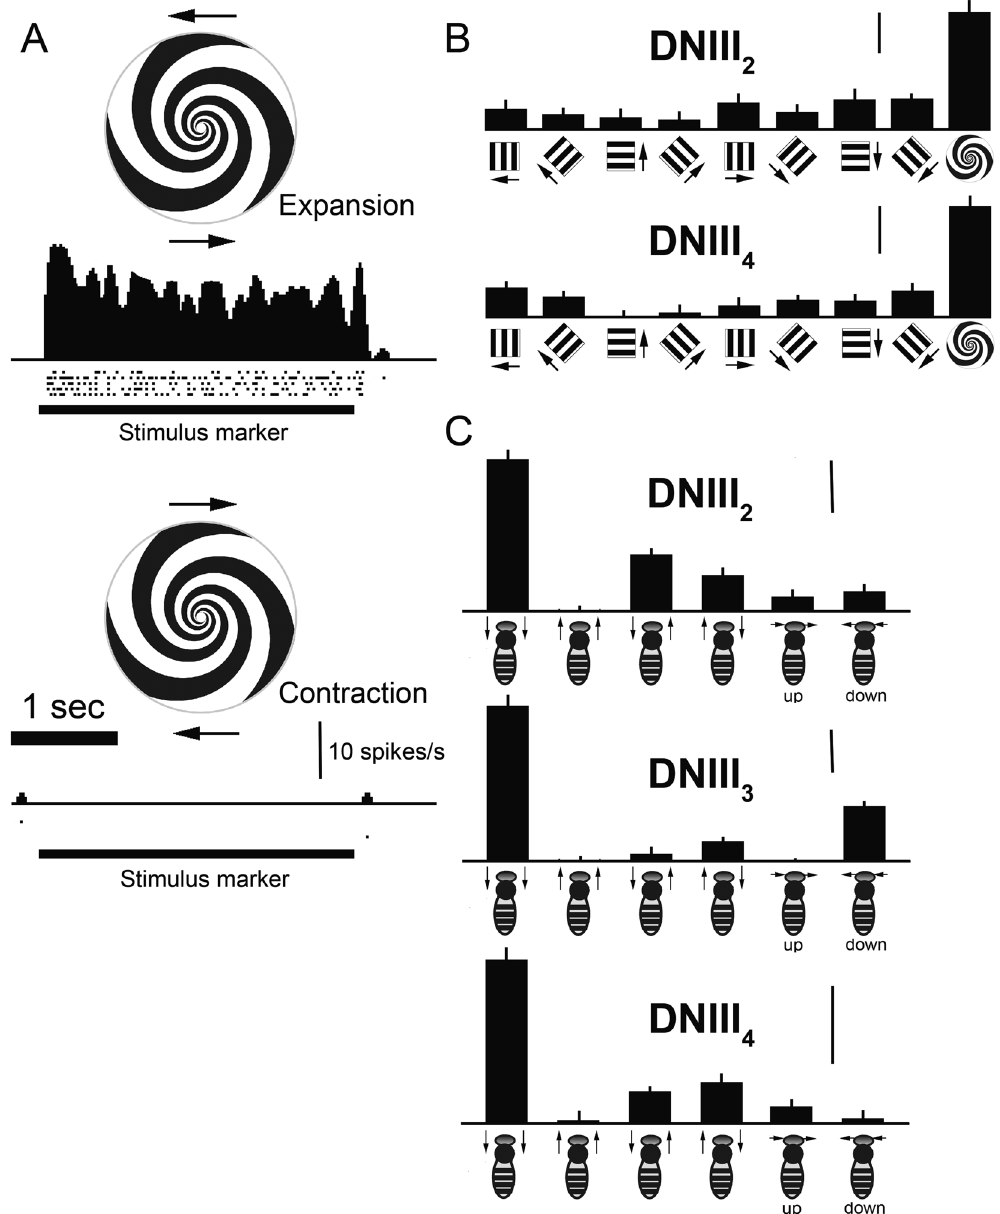
Figure 4. Directional tuning of DNIII neurons. ( A ) Response of a DNIII 4 neuron to expansion and contraction of the spiral pattern. The stimulus was repeated 5 times: rasters show actual spike arrival times and the spike density function shows the general response waveform. The spiral rotated at 1.5 revolutions per second. ( B ) Responses of DNIII 2 and DNIII 4 neurons, confirmed through anatomical identification of the brain anatomies, to frontal stimulation with gratings and spirals. ( C ) Responses of anatomically confirmed DNIII 2 , DNIII 3 and DNIII 4 neurons to lateral stimulation, as indicated. Error bars are standard errors. The vertical bars in ( B ) and ( C ) show 10 spikes/s. The stimuli in ( B ) and ( C ) were standardized gratings of 0.05 cycles per degree moved at 20 Hz for 1 s. The depictions of the stimuli below the graphs are to guide the reader – they are not accurate depictions of the spatial frequencies